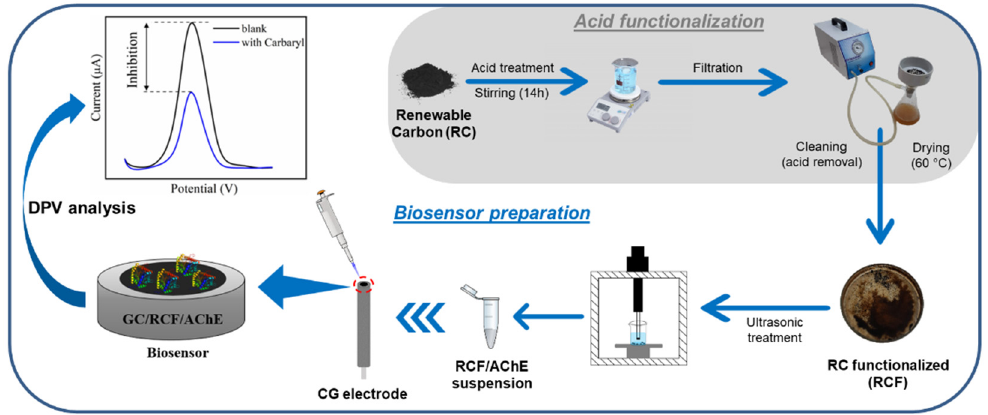
Figure 1. Schematic representation of RC functionalization and biosensor